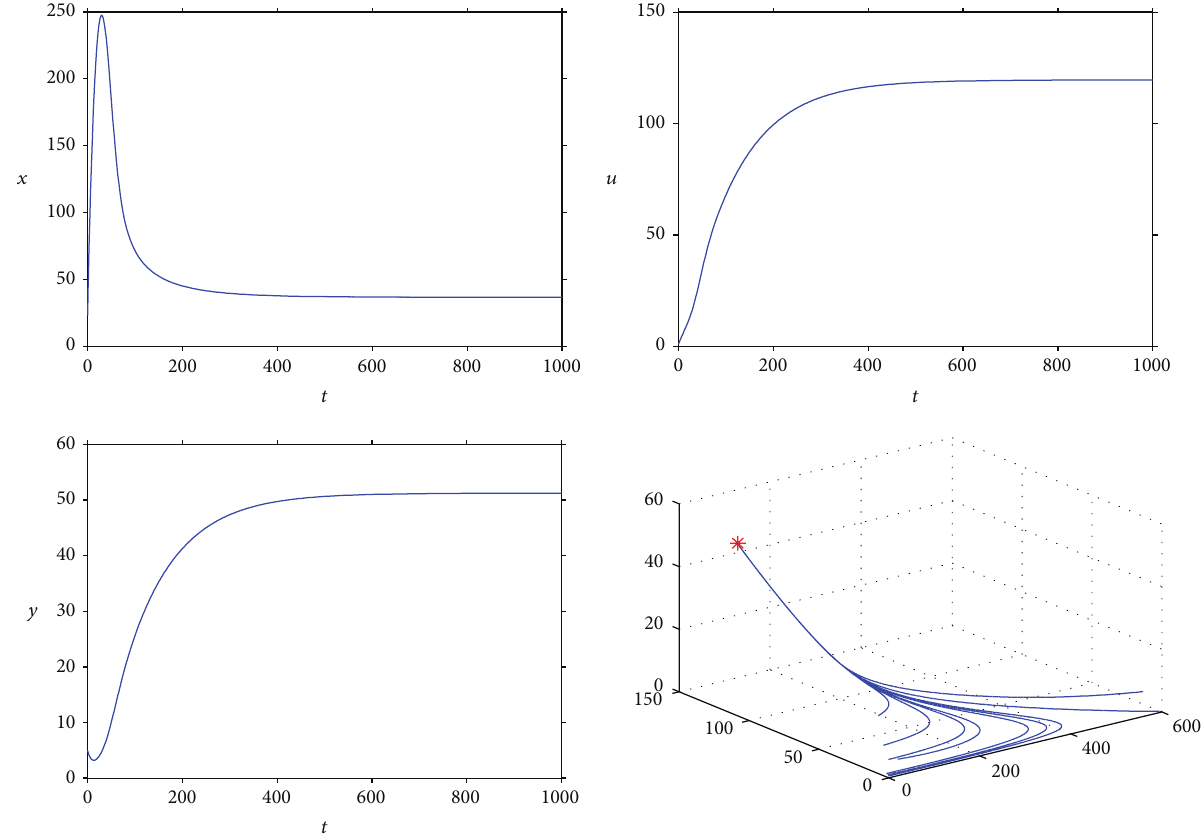
Figure 3: Global stability of the infection-free equilibrium 𝑃 1 when 𝑅 0 > 1 .